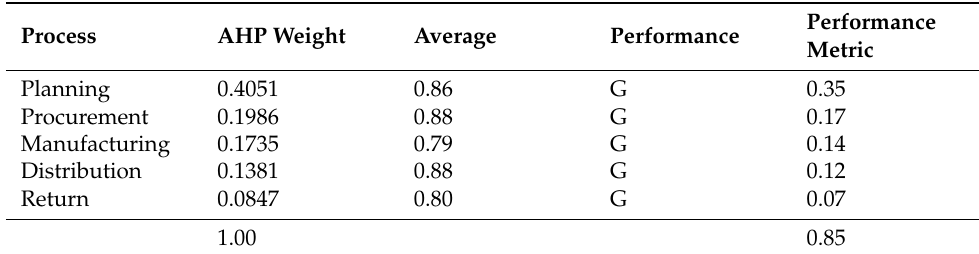
Table 7. Calculation of the sector-level performance